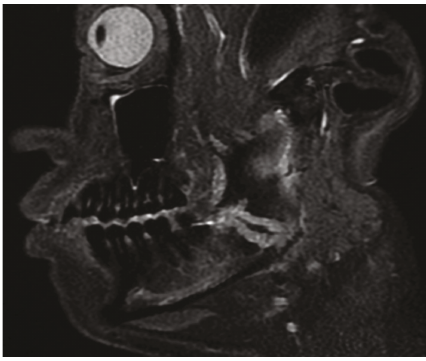
Figure 4: Sagittal magnetic resonance imaging (MRI) obtained during the initial visit. MRI shows that the mandibular bone marrow from the right ramus to the body has a high signal density on short-tau inversion recovery (STIR) images and the cortical bone is partially raptured. Moreover, fi laments in the low-density area are observed in the high-density area.